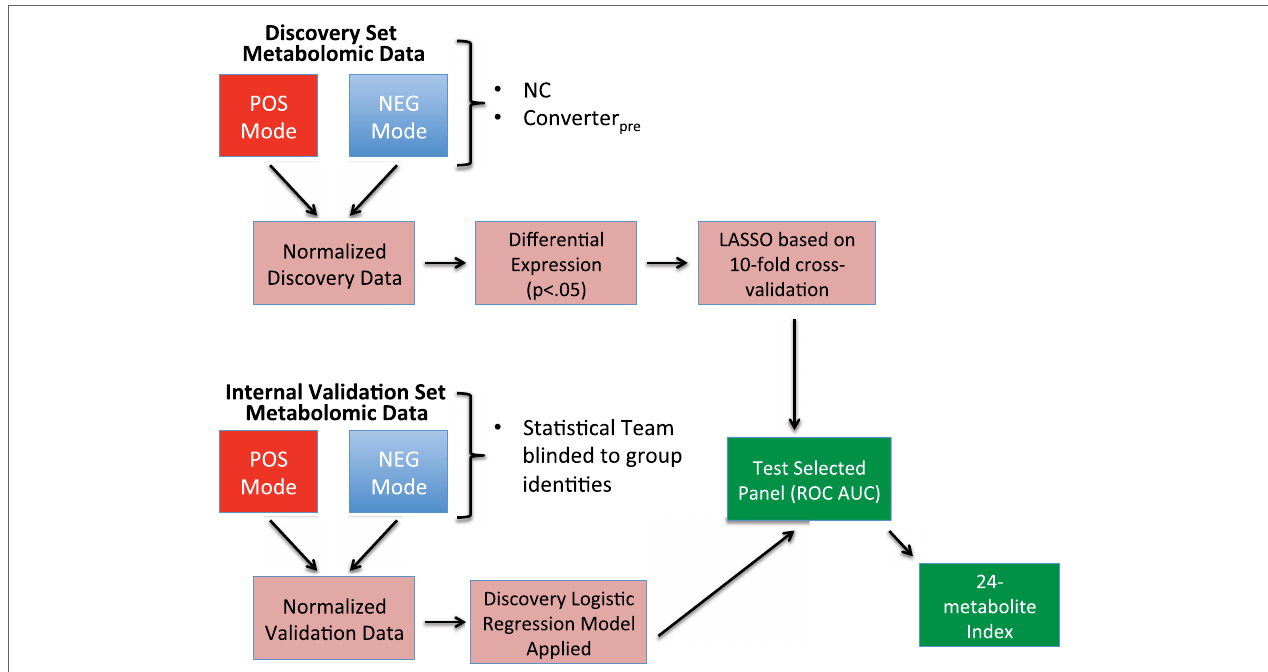
FigUre 2 | Flow chart showing steps in biomarker model development . Discovery cohort information was obtained from baseline specimen metabolomic data from subjects who remained cognitively normal (NC) throughout the study and baseline specimens from those that phenoconverted (Converter pre ) during the study’s first 3 years. Discovery metabolomic data from positive and negative modes underwent normalization, followed by selection of significantly altered metabolites ( p < 0.05), which were then annotated. The significant, annotated biomarker panel was then defined via a regularized learning method that features the LASSO restriction. The discovery biomarker panel selected is then tested using the receiver operating characteristic area under the curve (ROC AUC) method. With the statistical team blinded to group identities, the Internal Validation cohort data were similarly normalized and annotated. Internal Validation data were subjected to the results of the discovery logistic regression classifier and tested using the ROC AUC method. Combined data from the discovery and internal validation sets were used to develop a 24-metabolite